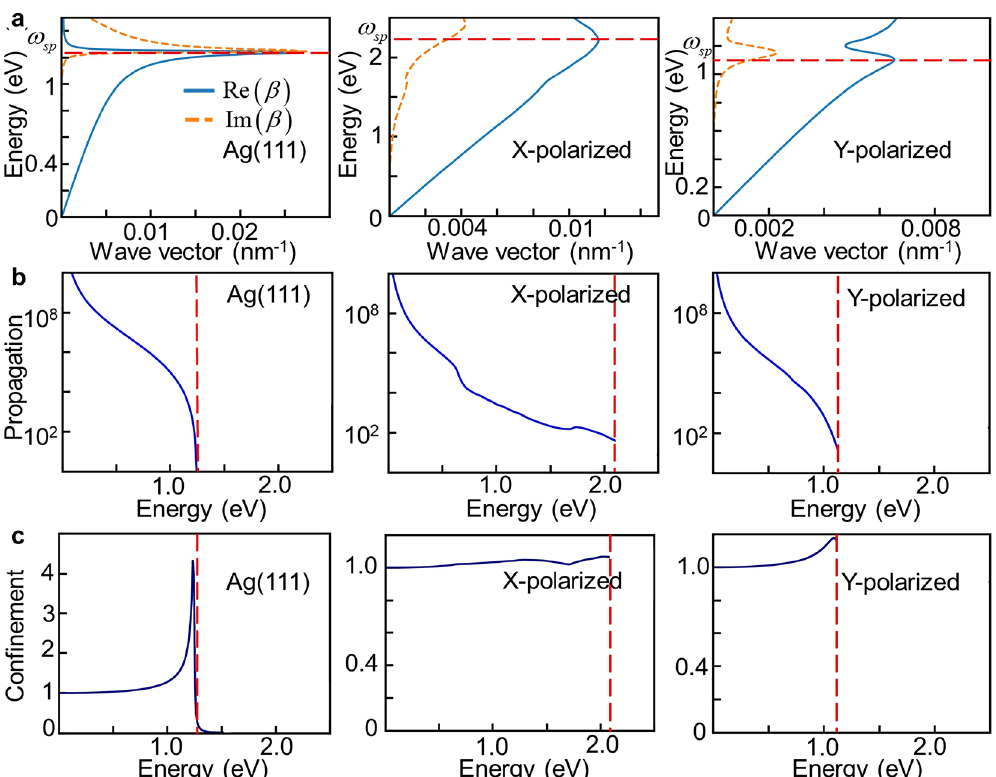
Figure 5: Plasmon dispersions and figures of merit of Ag(111) monolayer and borophene monolayer. (a) Plasmon dispersion. (b) Effective propagation length expressed with the ratio Re ( β ) resultsforAg(111)monolayer,andthemiddle(right)panelsforborophenemonolayerfor X -( Y -)polarizedlight.Theredlinesindicatethevalues of surface plasmon frequency ω sp . The energy in (a) – (c) indicates the plasmonic response frequency. Obviously, the plasmonic response frequency of borophene monolayer for X -polarized light extends to the visible light range ( ω sp = 2.21